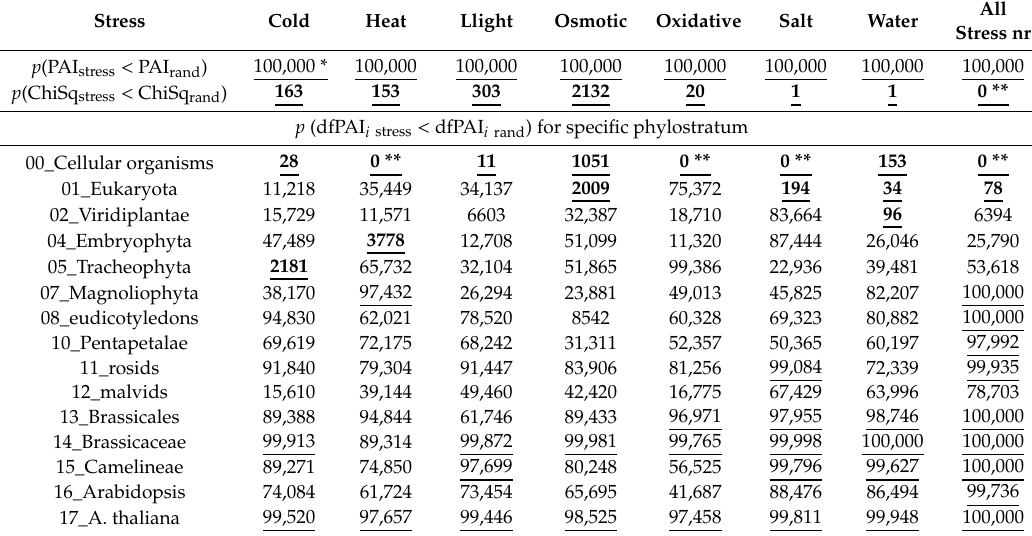
Table 3. The comparison of the PAI distribution of genes in the gene networks of A. thaliana stress response with the corresponding distribution of the complete set of A. thaliana genes according to the results of the permutation test. First line: types of stress. Second line: the proportion of random samples for which the average PAI rand value for a set of genes, the same size as the stress network, exceeds the PAI stress value for the corresponding stress network. Third row: fraction of random samples of genes in which the value of the quadratic deviation ChiSq rand distribution of ages the distribution for all genes is higher than in the corresponding gene networks (ChiSq stress ). The fifth and subsequent lines: the fraction of random samples of genes in which the di ff erence between the proportions of genes of i -th phylostratum dfPAI i among stress genes exceeds the corresponding proportion among random sample formed from the whole gene set. All values in the cells must be multiplied by 10 − 5 . PAI is calculated at the level of similarity of the sequences of ID =